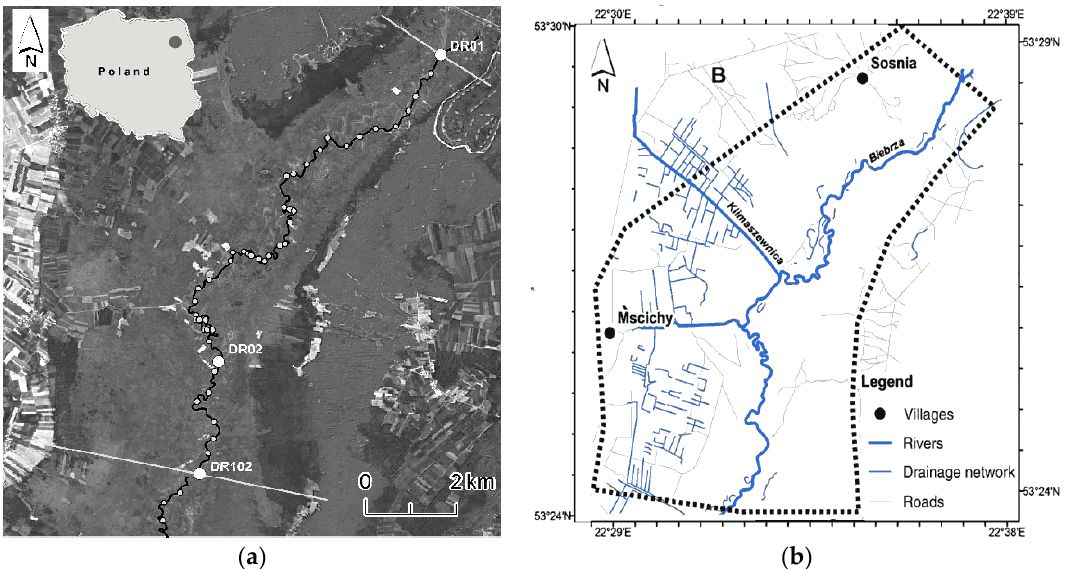
Figure 1. Study area. ( a ) Northern stretch of the Lower Biebrza Valley, starting at the cross-section DR01 and ending at DR102, DR02 denotes the localization of the automatic sensor (observation point), locations of remaining cross-sections are marked with dots [46]; ( b ) Northern part of the Lower Basin of the Biebrza with dashed lines showing Digital Terrain Model (DTM) area.